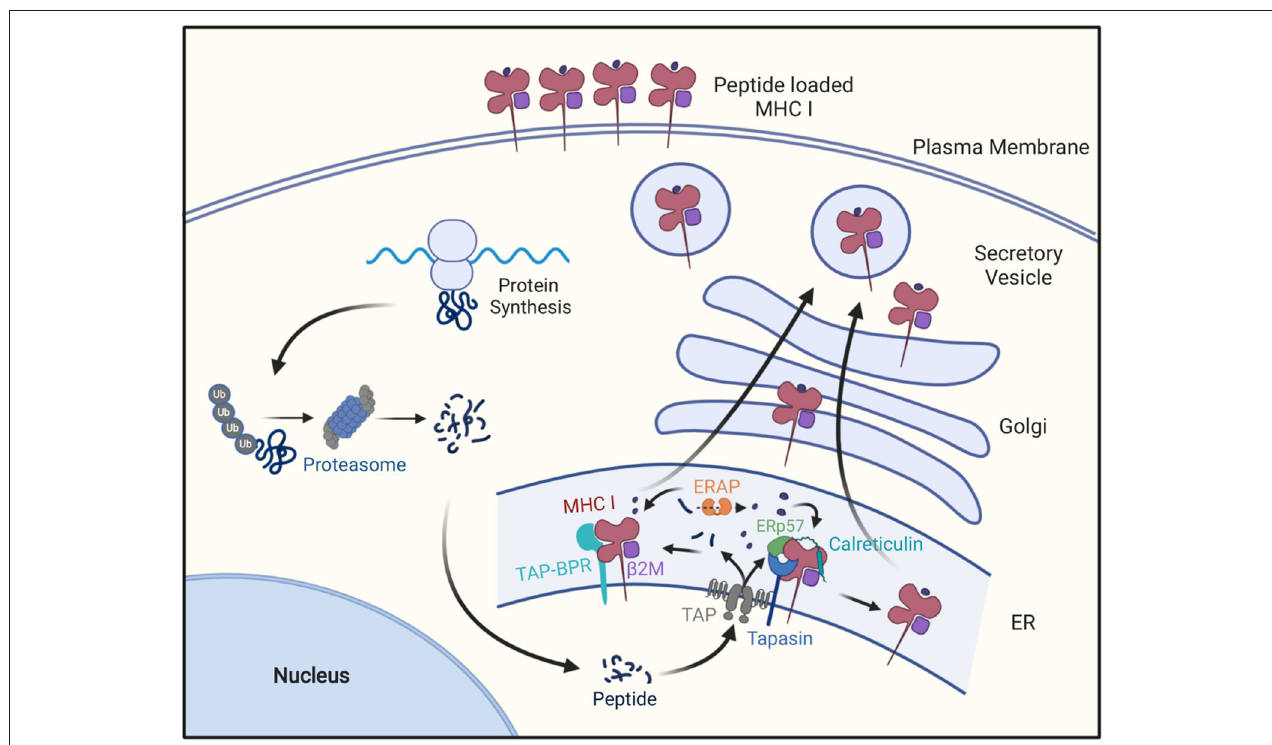
FIGURE 1 | The MHC class I antigen presentation pathway. Cellular proteins are hydrolyzed by the ubiquitin-proteosome pathway into oligopeptides, which are subsequently transported into endoplasmic reticulum through the TAP transporter. In the ER these peptides may be further trimmed by ERAP1 and then peptides of the right length and sequence bind to MHC I molecules with the help of Tapasin in a peptide-loading complex containing Tapasin, TAP, calreticulim, and ERP57, or the with the help of TAPBPR. After MHCI molecules bind peptide, they are transported to the cell surface for display to CD8 + T